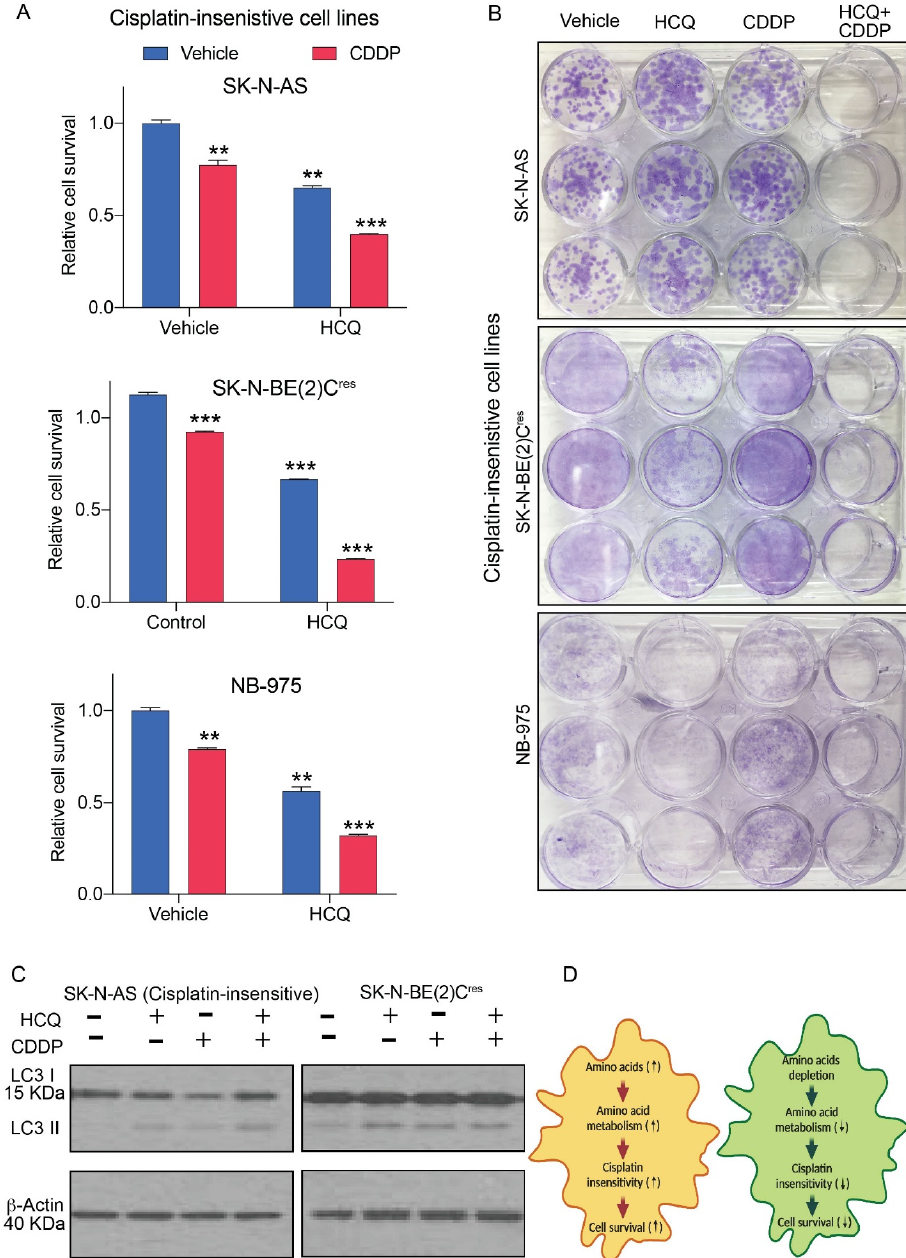
Figure 6. Hydroxychloroquine sensitizes neuroblastoma to cisplatin. ( A ) Bar graphs showing relative change in cell survival of CDDP-insensitive cells in the vehicle, HCQ, CDDP, and combination treatments for 72 h. Each bar in the graph represents mean ± SE of data obtained from 3 or 4 biological replicates. ** and *** represent a p < 0.01 and p < 0.001, respectively, obtained through Student’s t -test. ( B ) Pictures showing changes in survival of CDDP-insensitive cells in the vehicle, HCQ, CDDP, and combination treatments after ten-day treatment with conditions shown in panel. ( C ) Western blots showing changes in LC3I/II band intensities in control and drug-treated CDDP-insensitive cells. β -Actin was used as a loading control. ( D ) Schematic model summarizing that importance of amino acid metabolism in promoting cisplatin-resistance and survival in